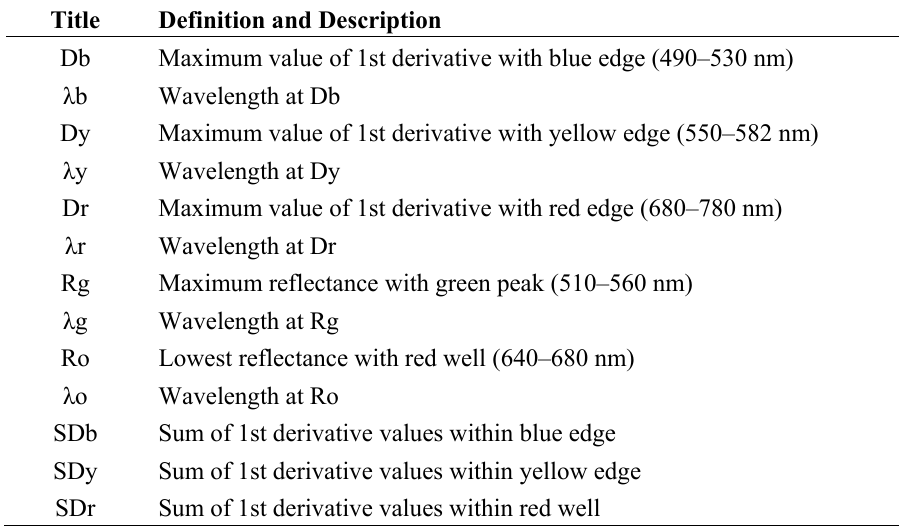
Table 2. Spectral features derived from first derivative